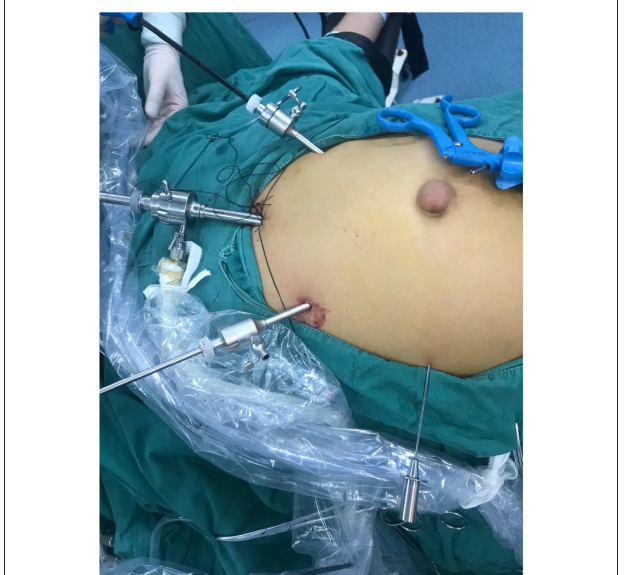
FIGURE 1 | Punch position.